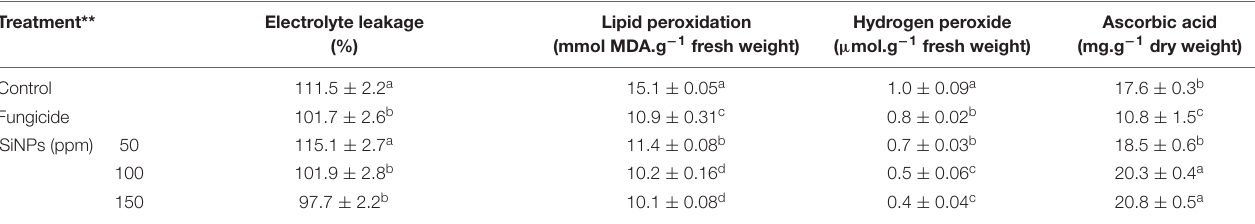
TABLE 8 | Effects of foliar application of SiNPs on the chemical properties of berries of grapevines infected with downy mildew at 50 days from the fourth spray.* Treatment**